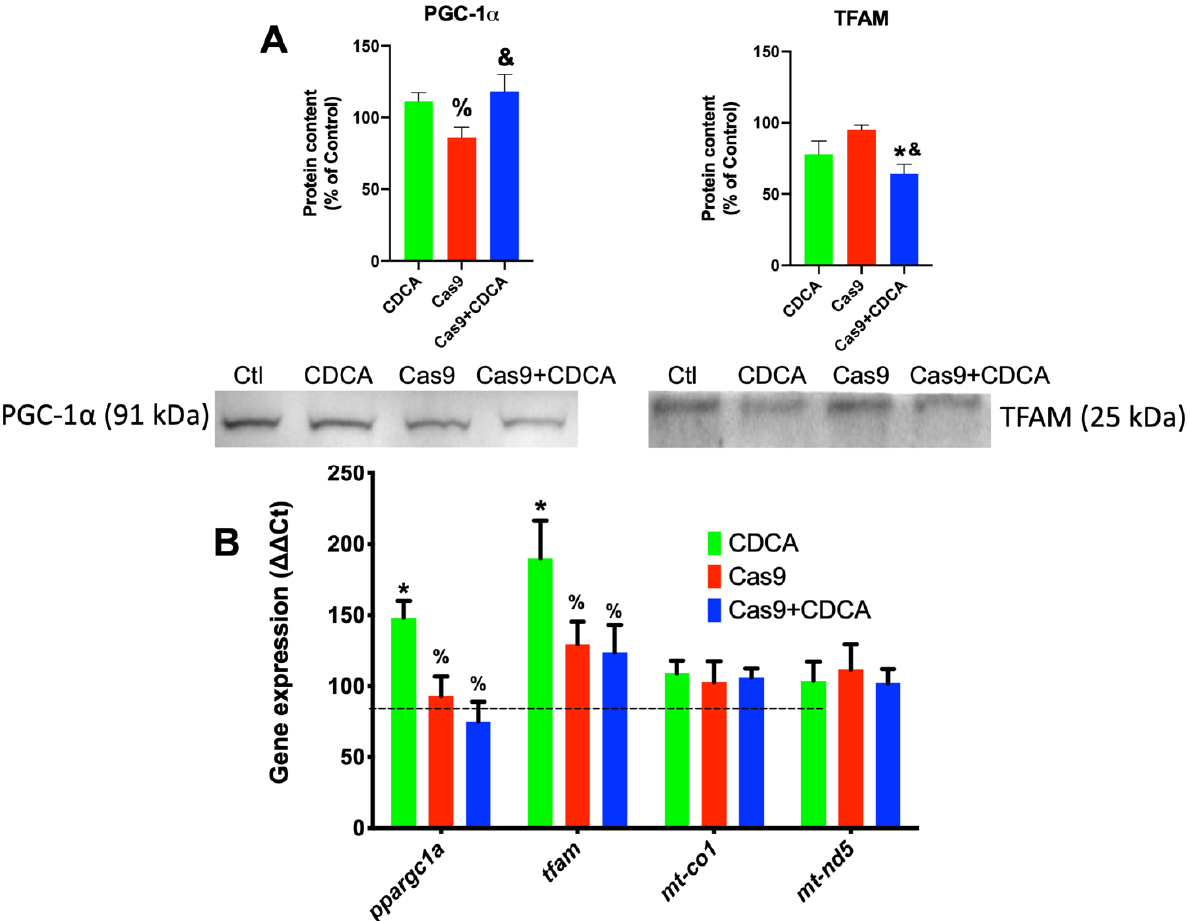
Figure 4. Gene expression and protein content for key elements of mitochondrial biogenesis in 3T3-L1 adipocytes exposed to CDCA in the absence or presence of TGR5. ( A ) Representative Western Blot for PGC-1 α and TFAM; ( B ) Gene expression for PGC-1 α ( ppargc1a ), TFAM ( tfam ), COX I ( mt-co1 ), and mtND5 ( mt-nd5 ). PGC-1a—Peroxisome proliferator-activated receptor gamma, coactivator-1alpha; TFAM—Transcription factor A, mitochondrial; COX I—Cytochrome c oxidase, subunit 1; mtND5—NADH-ubiquinone oxidoreductase, subunit 5. Data are derived from seven independent experiments, and bars represent means ± SEM. * indicates a statistically significant difference vs. Control ( p < 0.05); % indicates a statistically significant difference vs. CDCA ( p < 0.05); & indicates a statistically significant difference vs. Cas9 ( p <